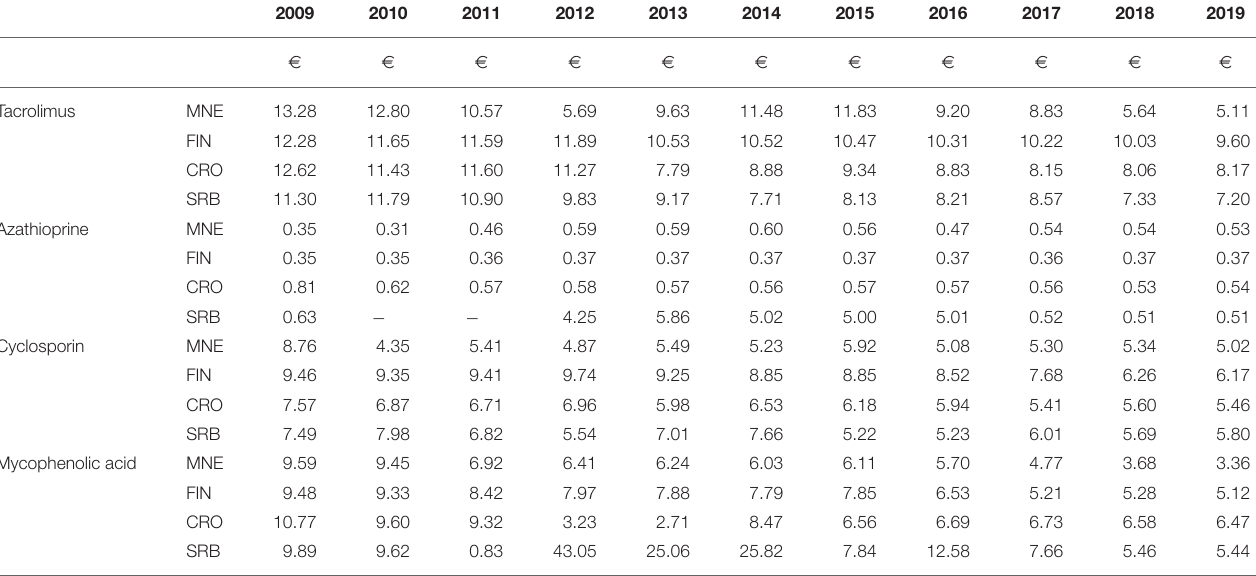
TABLE 2 | Overview of the prices of 1 DDD tacrolimus, azathioprine, cyclosporin and mycophenolic acid in Montenegro, Finland, Croatia and Serbia in the period 2009–2019, expressed in euros ( e